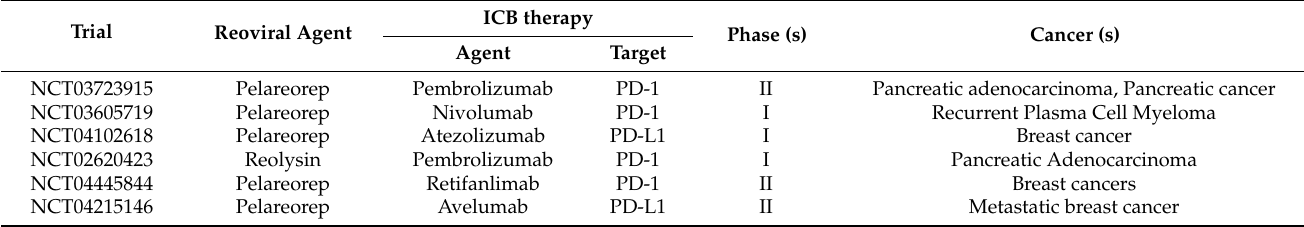
Table 2. List of clinical trials using reovirus in combination with immune checkpoint blockade therapies for various cancers. Trial